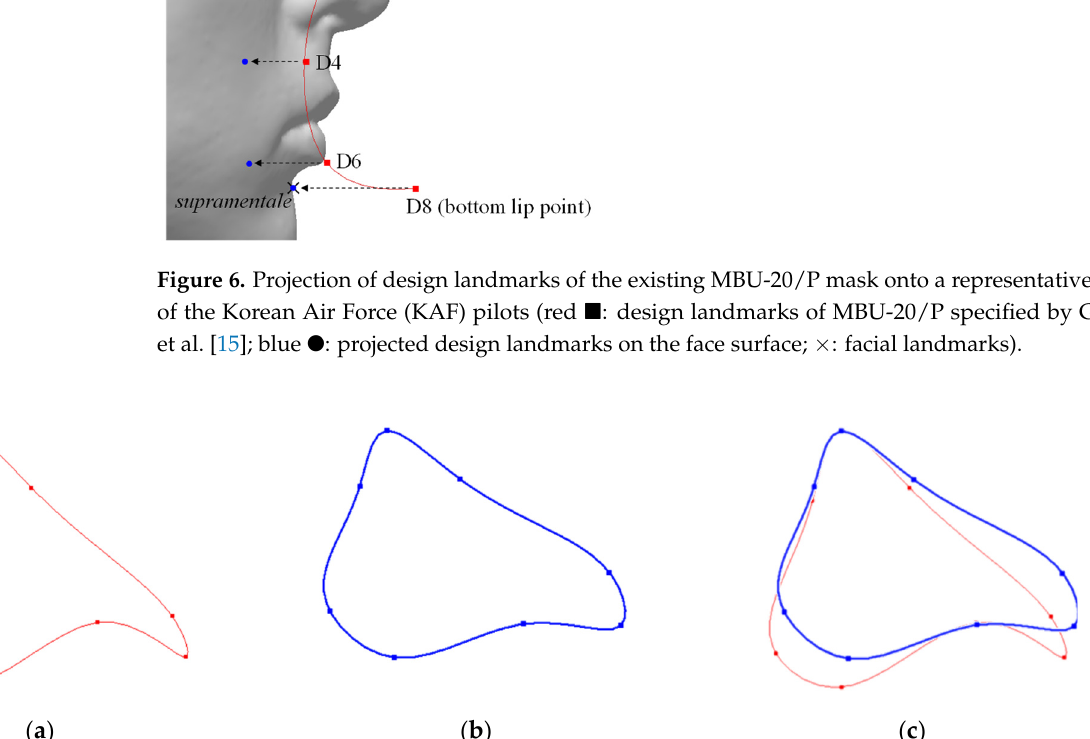
Figure 7. Boundaries of the existing and alternative oxygen masks. ( a ) The boundary of the existing MBU-20/P oxygen mask based on design landmarks specified by Gross et al. [15] ; ( b ) a boundary based on adjusted design landmarks identified by the projection of the existing design landmarks onto a representative face model of the Korean Air Force pilots; ( c ) the difference of the existing and alternative mask boundaries.